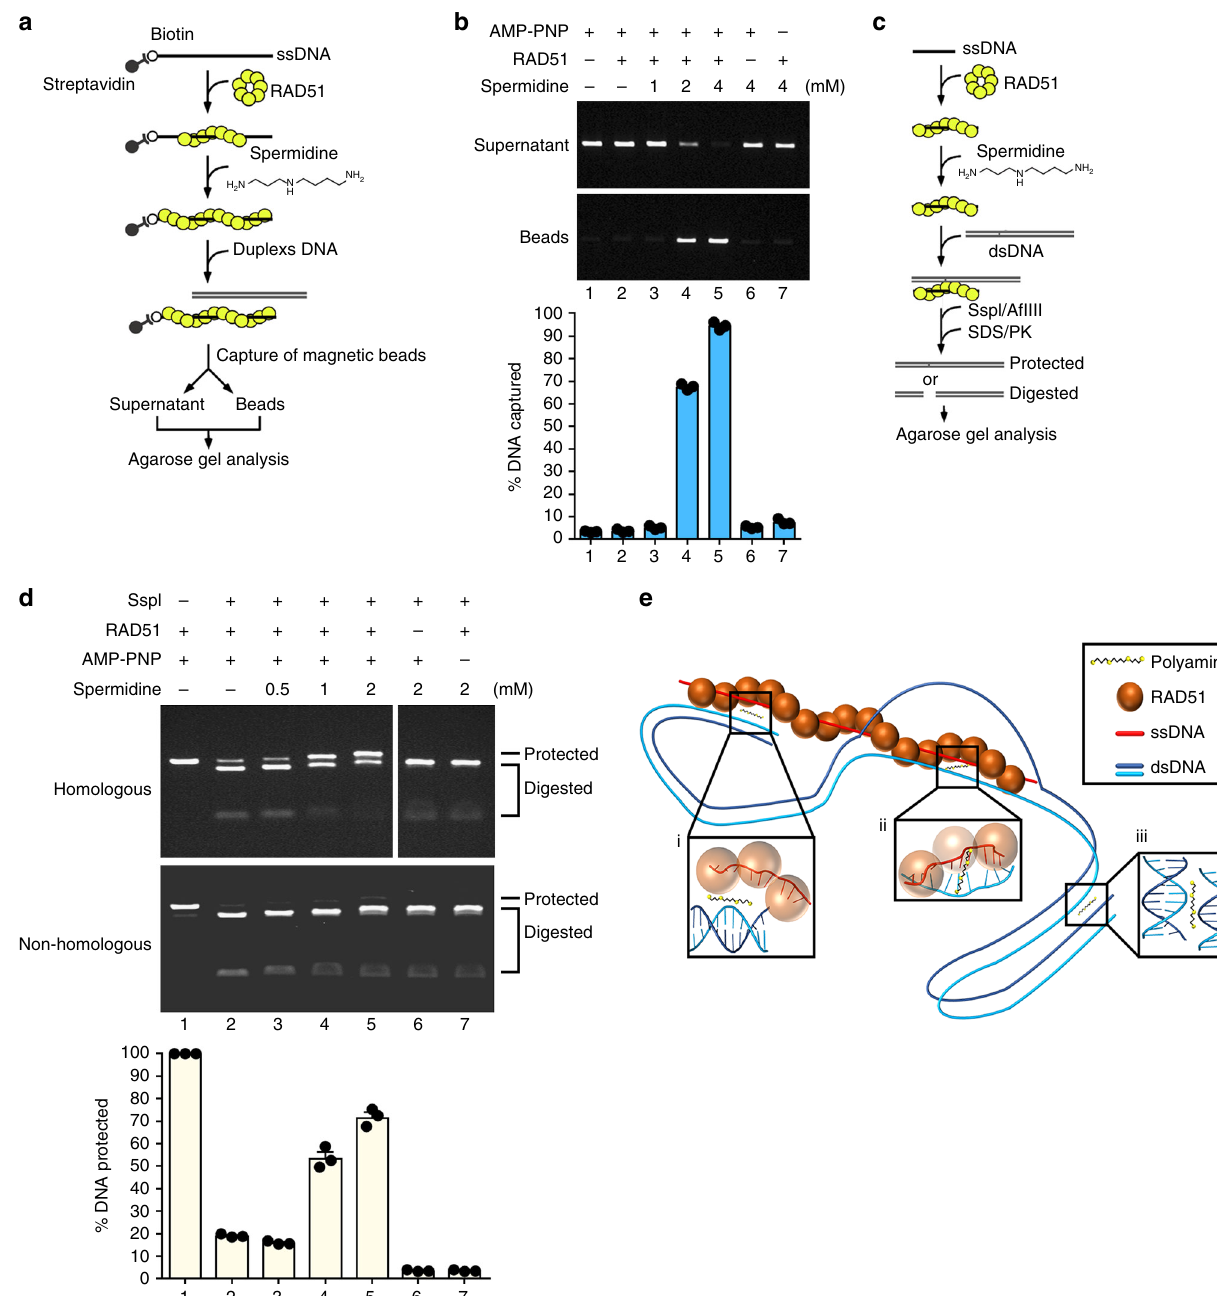
Fig. 4 Polyamines enhance duplex capture and synaptic complex formation by RAD51. a Schematic of the duplex capture assay. b Duplex DNA capture by the RAD51 presynaptic fi lament was examined without or with spermidine. Note that AMP-PNP was used as the nucleotide cofactor to assemble a stable RAD51 nucleoprotein fi lament. c Schematic of the synaptic complex assay. Brie fl y, RAD51 presynaptic fi lament was incubated with duplex DNA